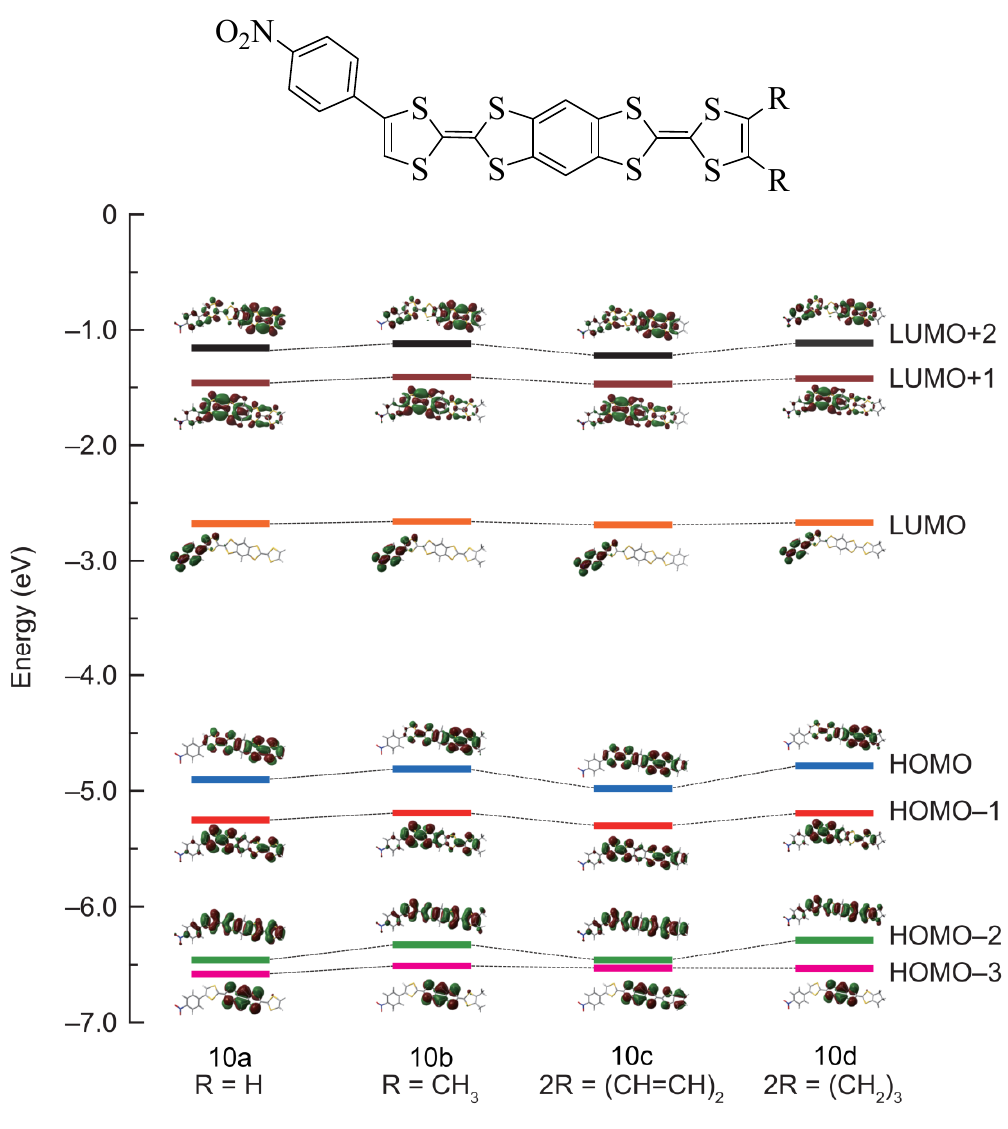
Figure 2. Levels of HOMO and LOMO of compounds 10a – d